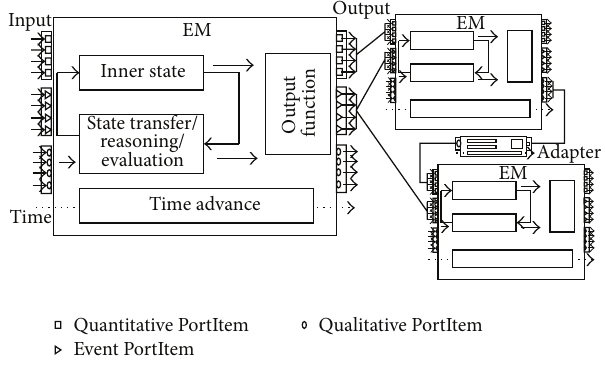
Figure 1: Modeling the complex system with component-oriented qualitative and quantitative integrated model.